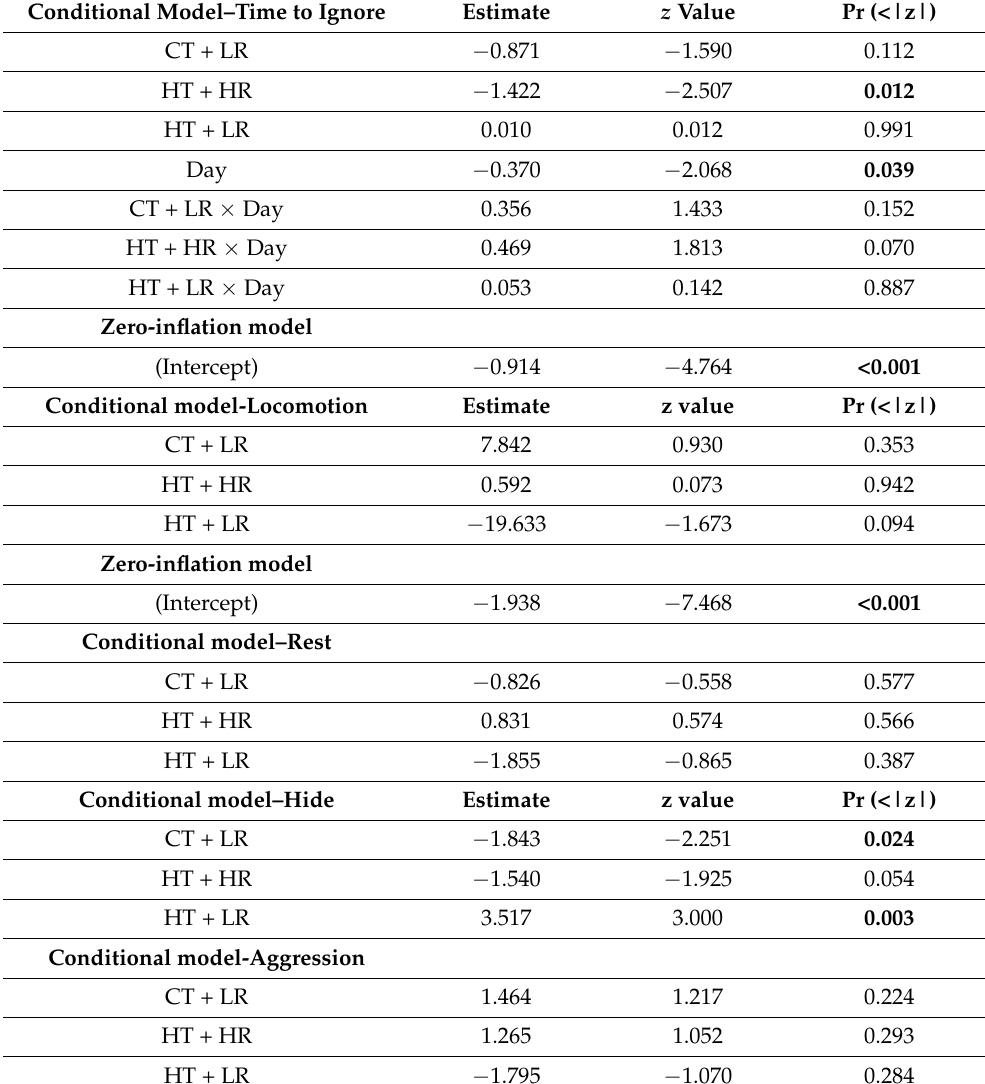
Table 2. Model coefficients for the generalized mixed model: time (in s) two-spotted goby, Po- matochistus flavescens took to ignore the observer (Time to Ignore), spent moving in the aquarium (Locomotion), or were resting, not swimming (Rest); frequency the fish hide in the aquarium (Hide), or showed aggressive behaviours (Aggression), during the observation period for the treatment conditions (temperature and ration) and day of observation. Bold text indicates significant treatment effects ( p ≤ 0.05) as compared to CT + HR. Conditional Model–Time to Ignore Estimate z